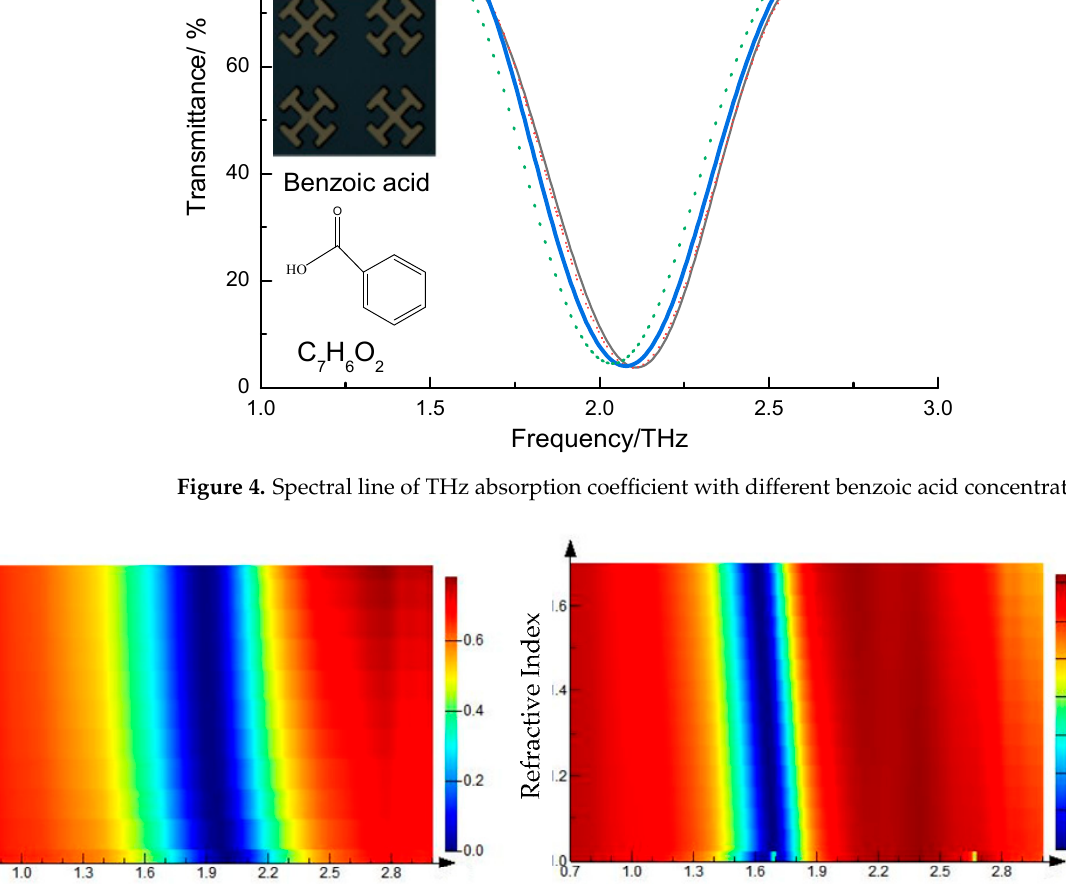
T = 2 µ m; ( b ) Variation of transmission spectrum with the refractive index of the coating—the refractive index of the coating